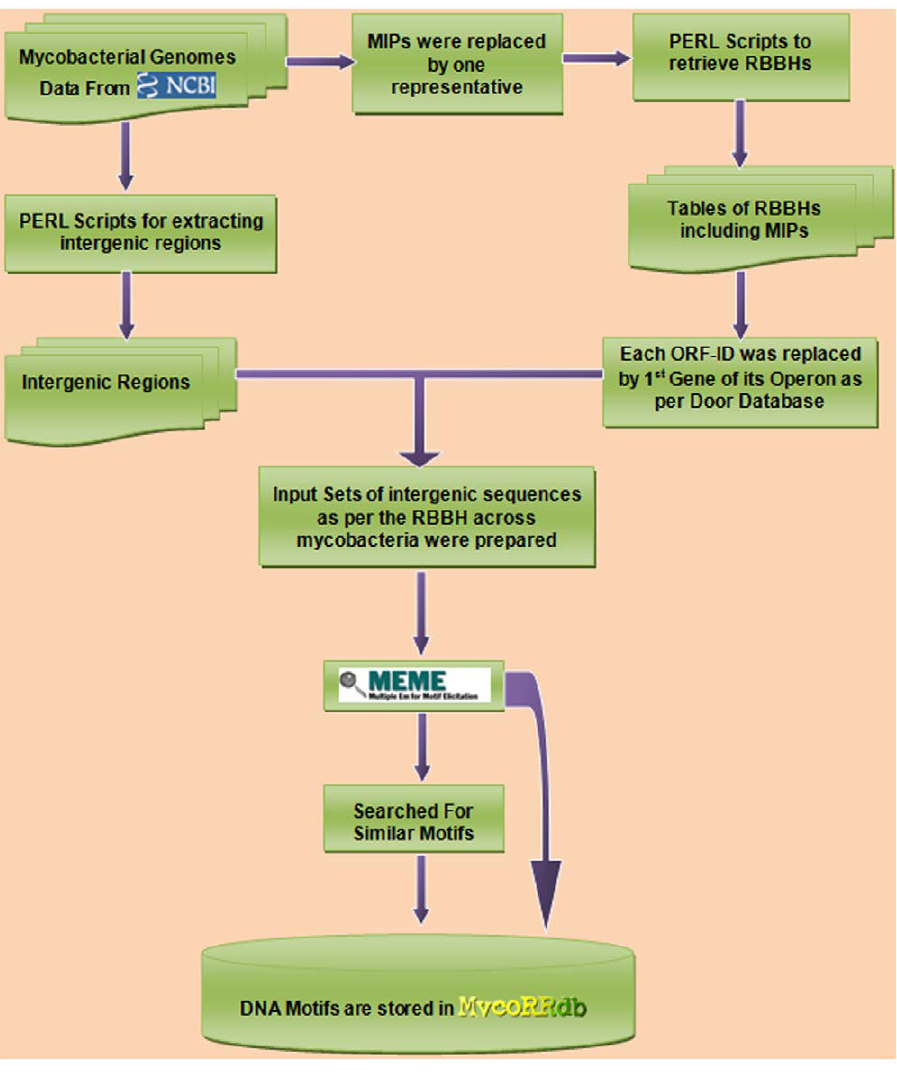
Figure 1. Flowchart of the methodology.